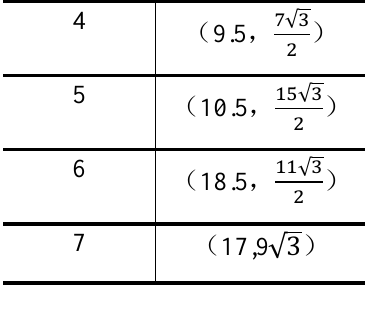
Table 3. The coordinates of each node of the vector line